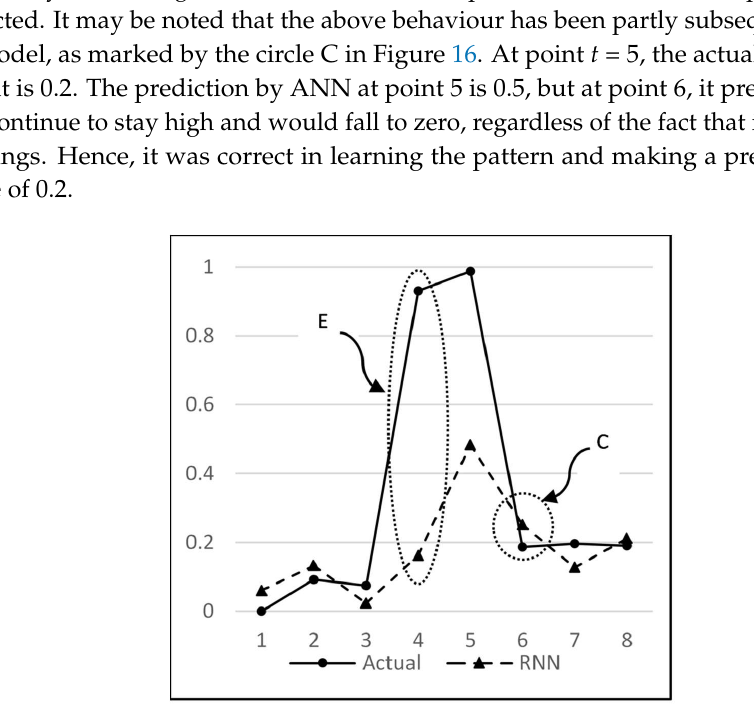
Figure 16. Points of misprediction marked by E and points of correct prediction marked by C.